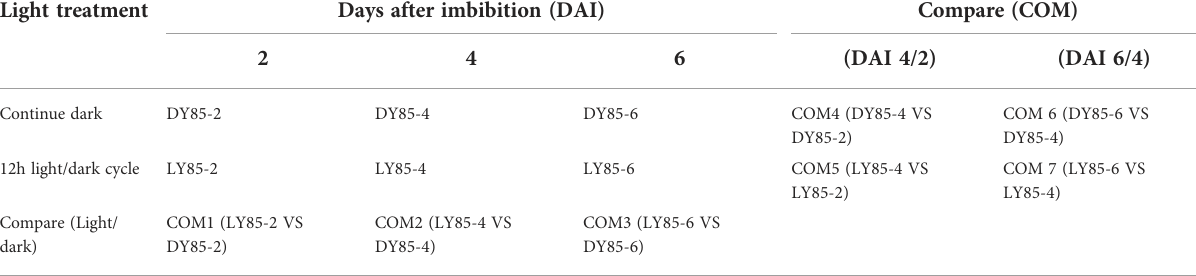
TABLE 1 The light treatment of germinated seed and developed seedling in tobacco. Light